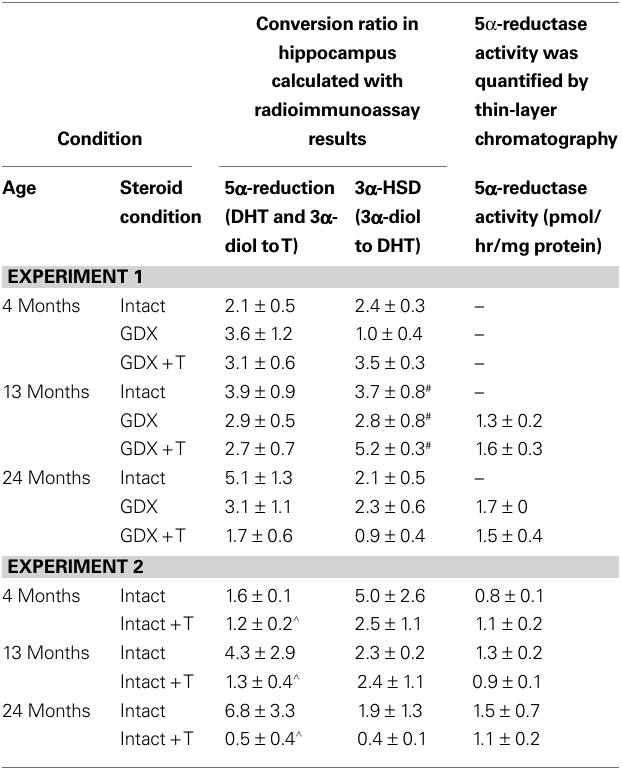
Table 5 | 5 α -reductase activity of 4-, 13-, and 24-month-old gonadally- intact (intact), gonadectomized (GDX), or GDX and T-replaced (GDX + T; Experiment 1) and intact or intact and T-administered (Experiment